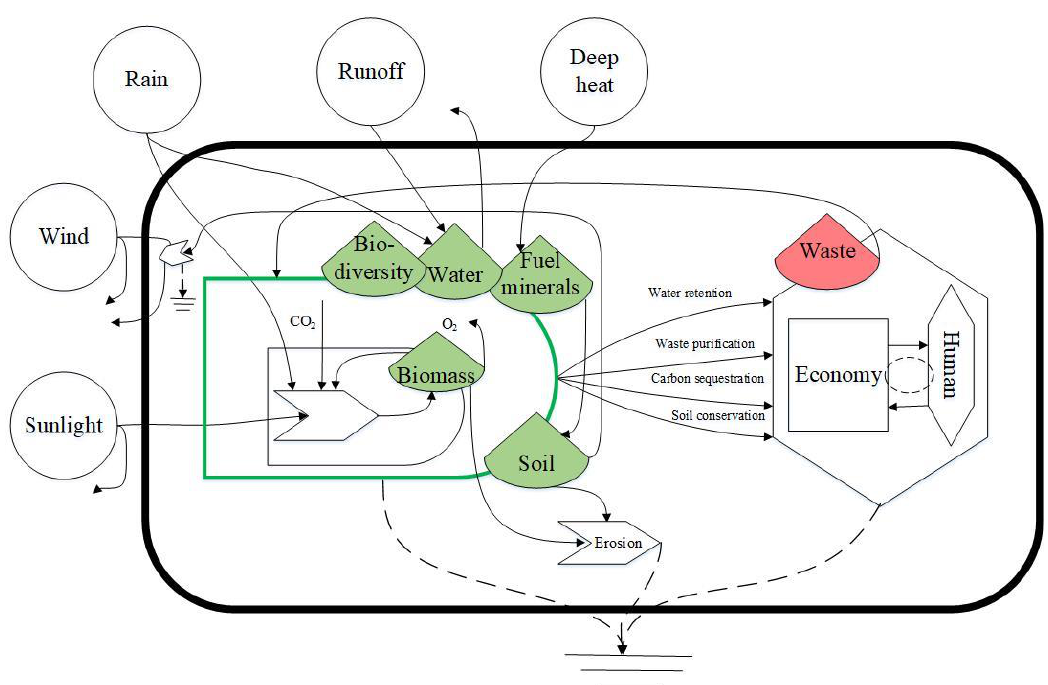
Figure 2. Emergy diagram of urban ecosystem services in this study.